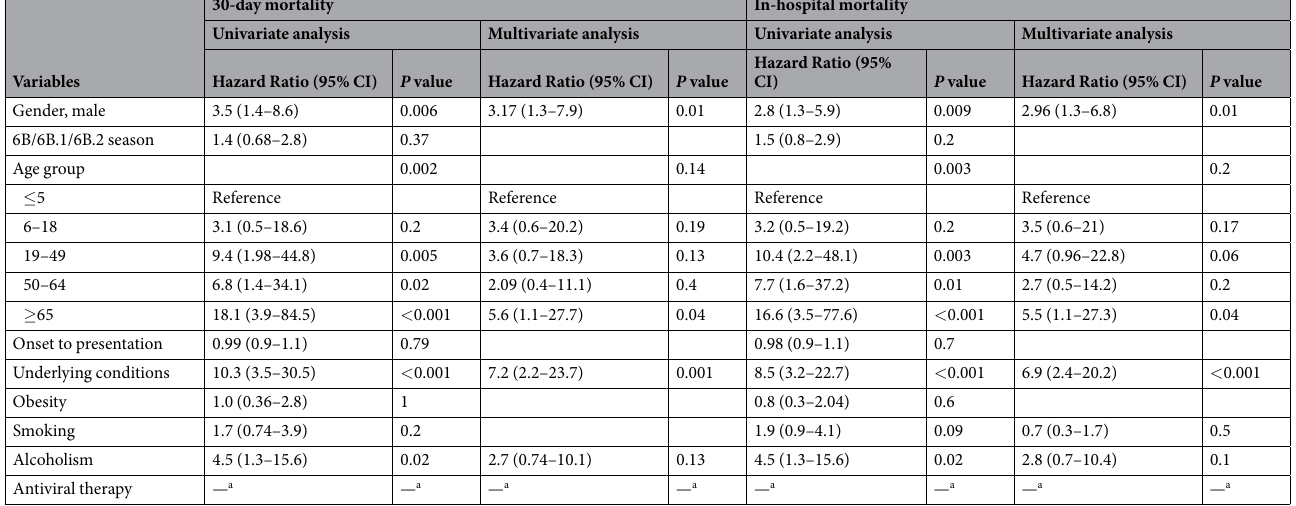
Table 6. Hazard Ratios for Influenza-related 30-days Mortality and In-hospital Mortality among 453 Hospitalized Patients. a Data cannot be calculated because none of the patients who did not receive antiviral therapy